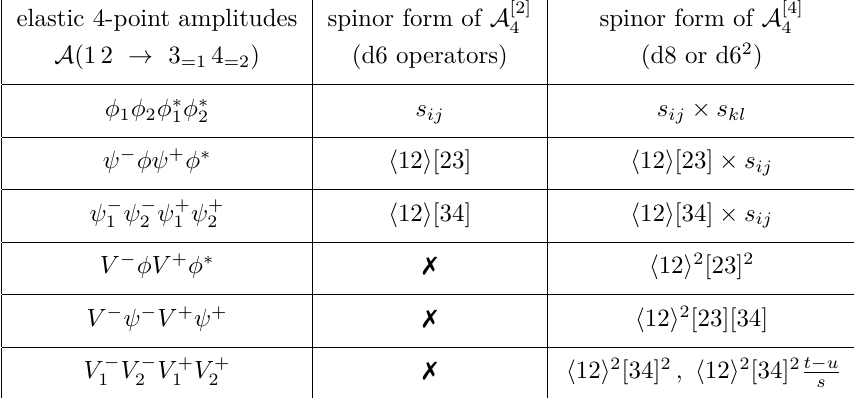
Table 1 . A full list of all possible 4-point elastic scattering amplitudes in the helicity basis, with the corresponding tree-level form with mass dimensions 2 (one insertion of dimension-6 operators) and 4 (dimension-8 or dimension-6-squared) in the massless case. We use φ , ψ and V to denote scalars, fermions and vectors, respectively. The + / − signs denote helicities in the usual all-in/all- out convention. The ordering of the particles is such that the incoming particle 1 is outgoing particle 3, and 2 is 4. The labels 1 and 2 are explicitly shown in the subscripts for scattering of the same particle type. The forward limit corresponds to t = s 13 → 0 . Amplitudes that can be obtained by crossing (such as A ( ψ − ψ + ψ + ψ − ) ) are not explicitly shown. The 7 mark denotes that one can 1 2 1 2 not write down a term that fulfills all the consistency requirements. s ij denotes a general linear function of the Mandelstam variables in the form c s s + c t t + c u u , where c s,t,u are